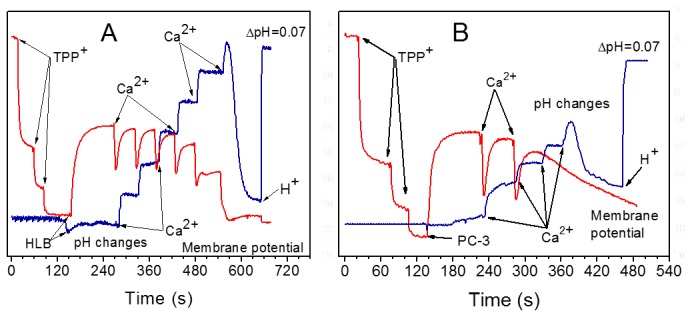
Changes in the membrane potential (red) and medium pH (blue) during titration of mitochondria with calcium.(A) Human lymphoblast mitochondria. (B) Mitochondria from PC-3 prostate cancer cells. Additions: TPP+ was added in 0.5 µM aliquots, final concentration 1.5 µM; Ca2+ 20 nmol/ml, HCl 125 nmol/ml caused ΔpH of 0.07.